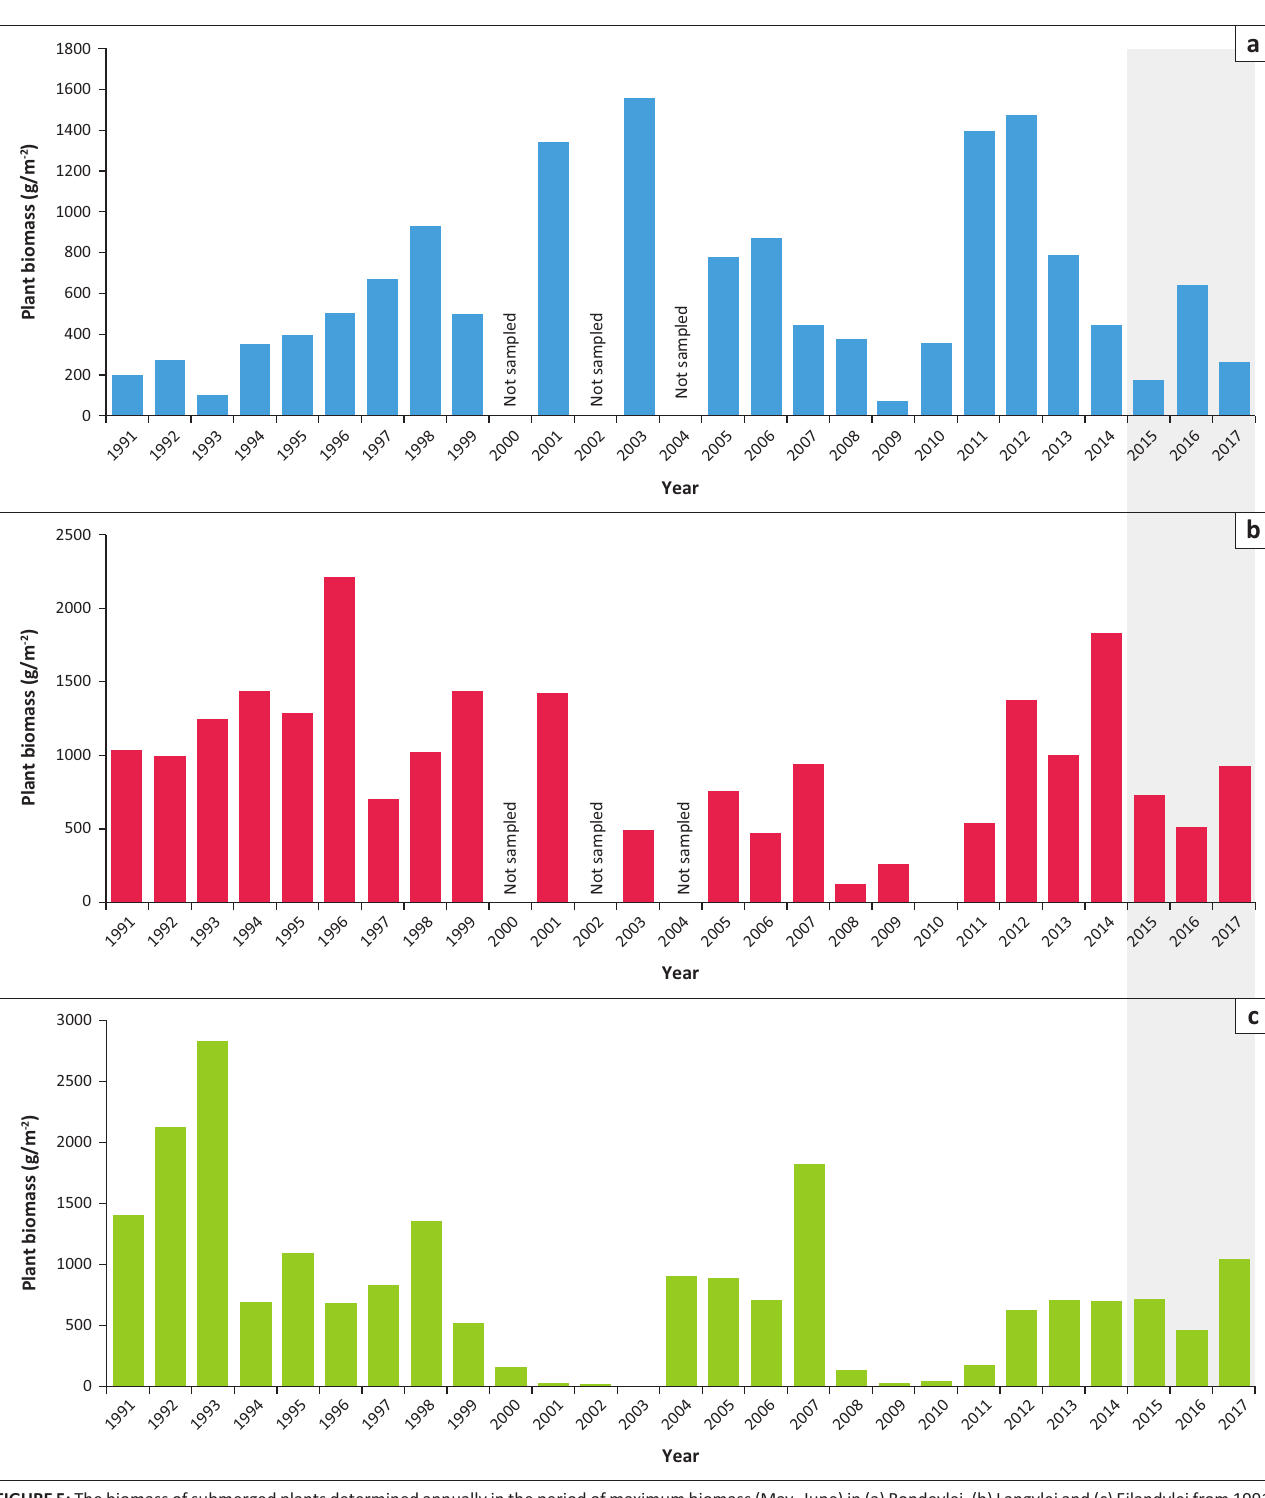
FIGURE 5: The biomass of submerged plants determined annually in the period of maximum biomass (May–June) in (a) Rondevlei, (b) Langvlei and (c) Eilandvlei from 1991 to